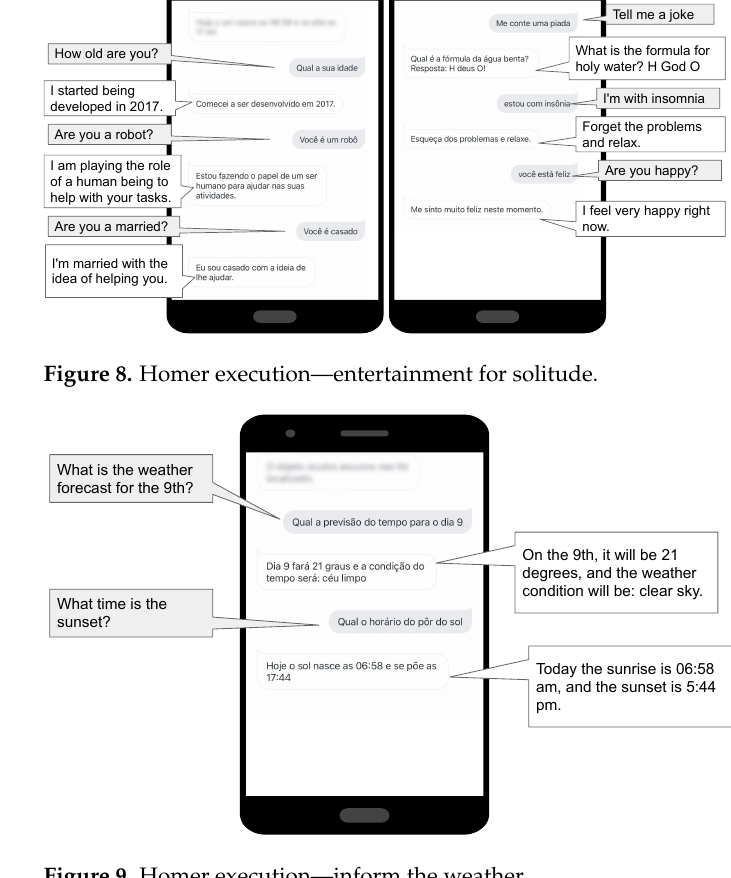
Figure 9. Homer execution—inform the